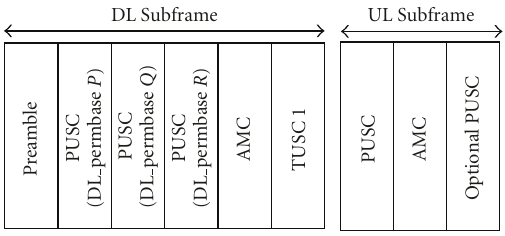
Figure 1: Multizone switching diversity frame structure.